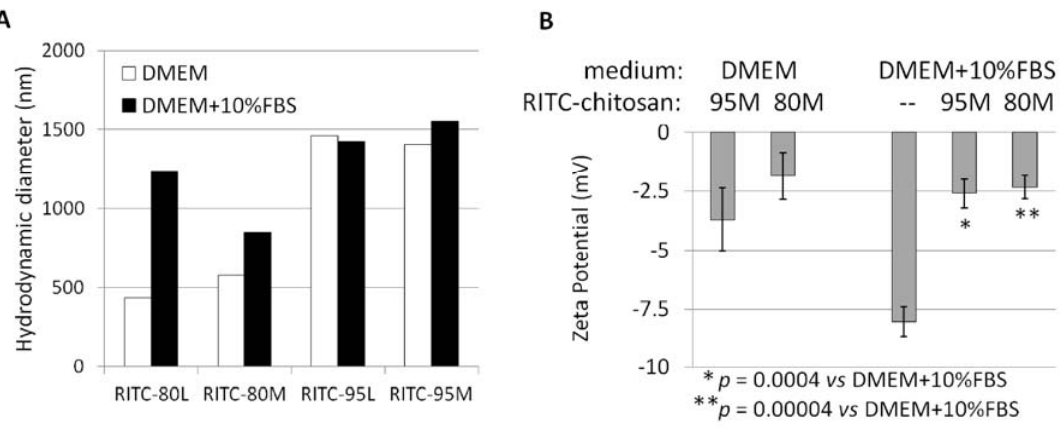
Figure 5. Average hydrodynamic diameter of the chitosan library with and without serum ( A ) and zeta potential of 50 µg/mL RITC-95M or RITC-80M chitosan in media without and with 10% serum (N = 3 to 4 measures, mean ± standard deviation, B